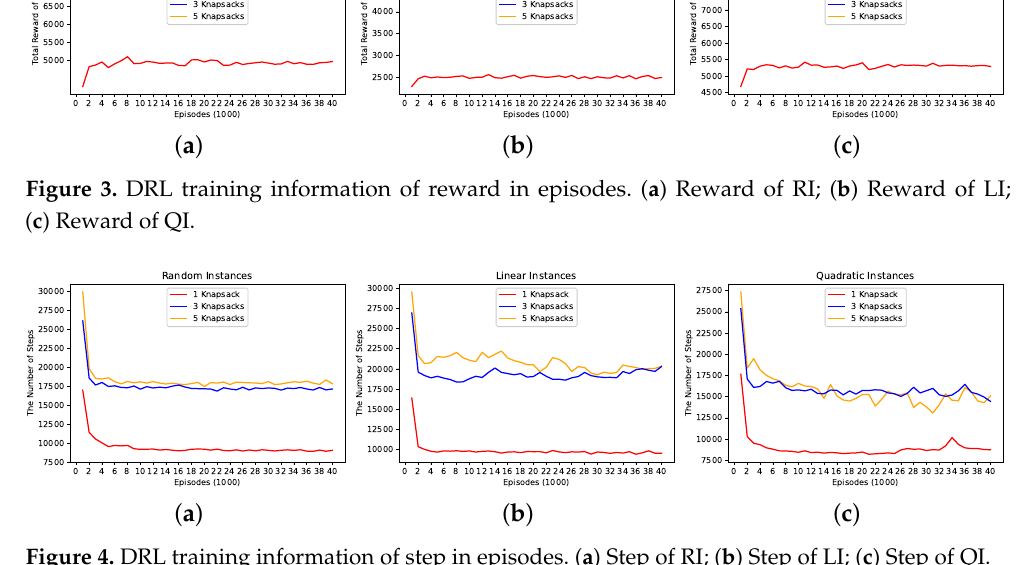
Figure 4. DRL training information of step in episodes. ( a ) Step of RI; ( b ) Step of LI; ( c ) Step of QI. Figure 3 represents accumulated rewards after each unit of 1000 episodes